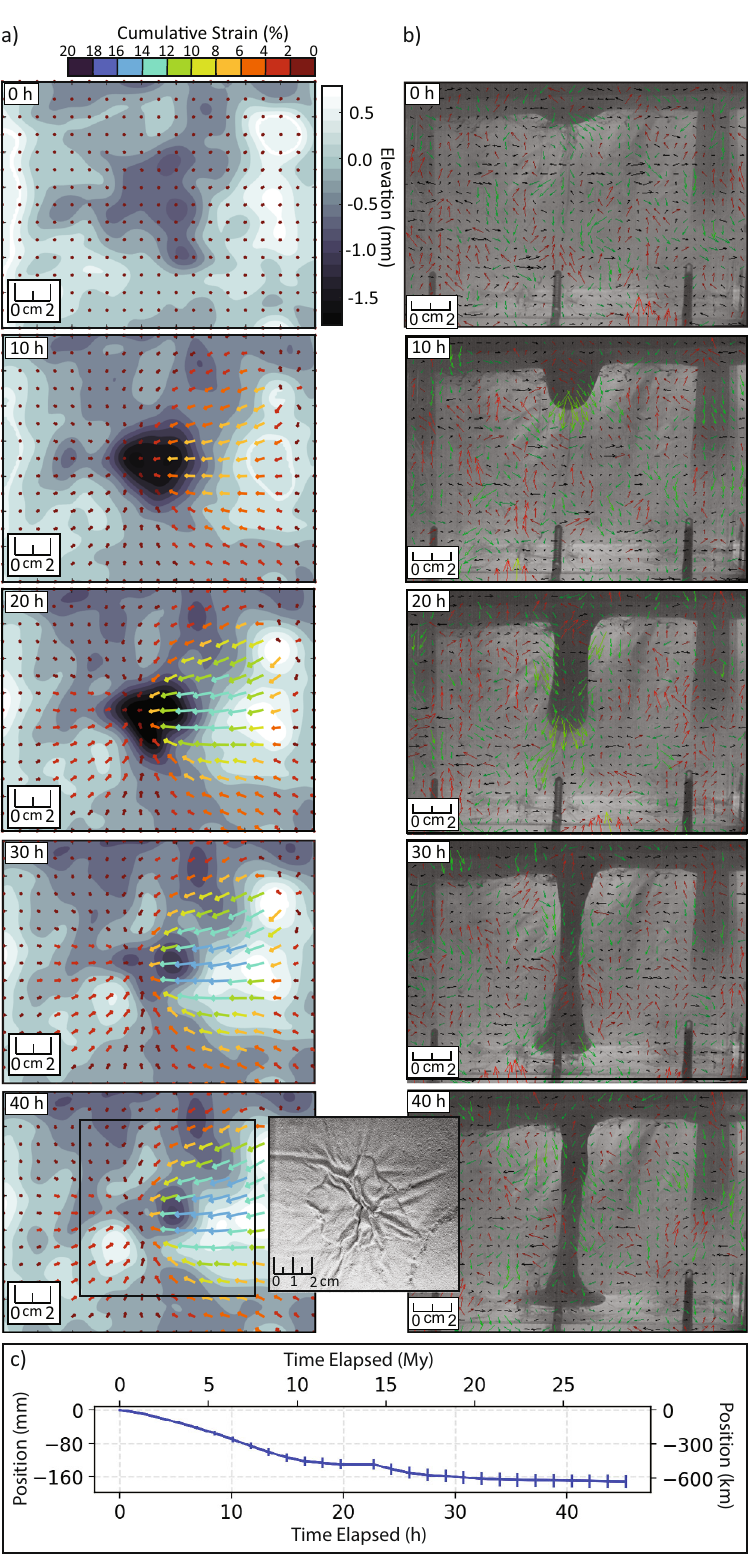
Fig. 2 Evolution of EXP-1. a Plan view showing the evolution of topography from 0 to 40 h for EXP-1 with arrows depicting cumulative surface strain. Convergence towards the centre occurs between 0 h to 40 h. Convergence stuctures are shown in the photograph at 40 h with a possible extensional feature in the bottom right corner. Note the presence of an air bubble in the top right corner of the images. b Below surface (sideview) evolution of the drip from 0 to 40 h. Green vectors track downward motion of the drip and red vectors the upward motion of the PDMS. c Progression of the drip through the mantle starting at the base of the mantle lithosphere (Position = 0) with corresponding scaled Earth time values. The drip touched the bottom of the box at ~35 h. Drip descent appears to cease at ~18 h before sinking again at ~23